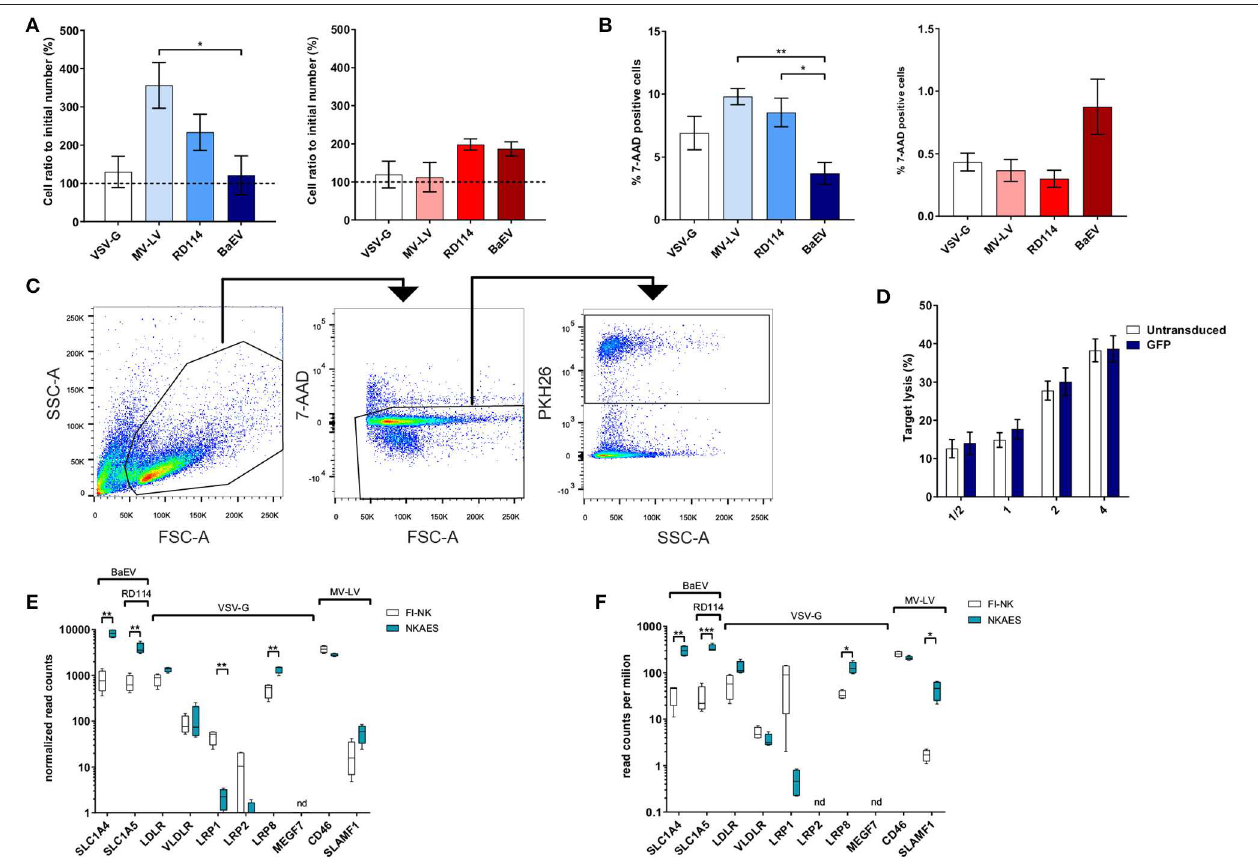
FIGURE 2 | BaEV-LV transduction does not alter the phenotype or function of NK cells. (A) Viability of NKAES (left panel; n = 3) or FI-NK (right panel; VSV-G and MV-LV n = 6, RD114 n = 3, BaEV n = 9) with different LVs was assessed via the ratio of living (7-AAD-negative) cells in the culture normalized to the initial number of cells before transduction (* p < 0.05 and p = 0.141 for NKAES and FI-NK, respectively; one-way ANOVA test with multiple testing and Bonferroni correction). (B) Cell death, assessed by the percentage of 7-AAD positive cells, of NKAES (left panel; VSV-G, MV-LV and RD114 n = 3, BaEV n = 8) or FI-NK (right panel; VSV-G and RD114 n = 6, MV-LV n = 3, BaEV n = 12) with different LVs. Percentage of 7-AAD positive cells was calculated by flow cytometry after debris exclusion (* p < 0.05 and ** p < 0.01 for NKAES, and p = 0.14 for FI-NK; one-way ANOVA test with multiple testing and Bonferroni correction). (C) Flow cytometry plot showing the gating strategy used in cytotoxicity experiments. Cells were first gated on forward and side scatter (FSC-A, SSC-A) and then the live 7-AAD negative cells were selected. Finally, PKH26 stained target cells were gated to numerate the remaining cells. (D) Cytolytic function of BaEV-LV-transduced vs. untransduced NKAES cells against K562 target cells. Data represent the percentage of target lysis, assessed by flow cytometry relative to the effector/target ratio and normalized to targets alone. ( p = 0.4012, 2-way ANOVA test with multiple testing and Bonferroni correction, n = 3). (E) Quantitative expression of the viral receptors mRNAs assessed by RNA-seq in NKAES expanded with K562mbIL21 and in FI-NK-cells ( n = 4, ** p < 0.01, multiple T -tests with Holm-Sidak correction). (F) Quantitative expression of the viral receptors mRNAs assessed by RNA-seq in NKAES expanded with K562mbIL15 and in FI-NK-cells ( n = 4, * p < 0.05, ** p < 0.01, *** p < 0.001, multiple T -tests with Holm-Sidak correction). Data are presented as the mean ± SEM, except where noted. For all experiments, NKAES and FI-NK were assessed at day 3 or day 5 post-transduction,